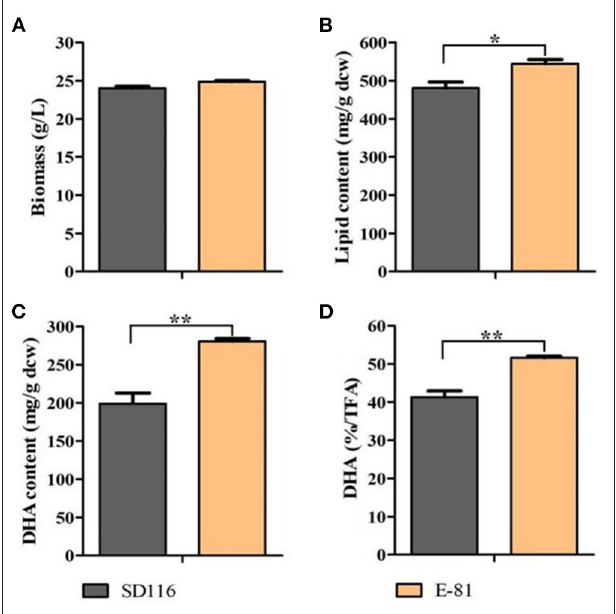
FIGURE 2 | Analysis of the biomass and lipid profiles in SD116 and E-81. (A) Biomass, (B) lipid content, (C) DHA content, and (D) DHA purity in total fatty acids (TFA). ** P < 0.01 and * P <